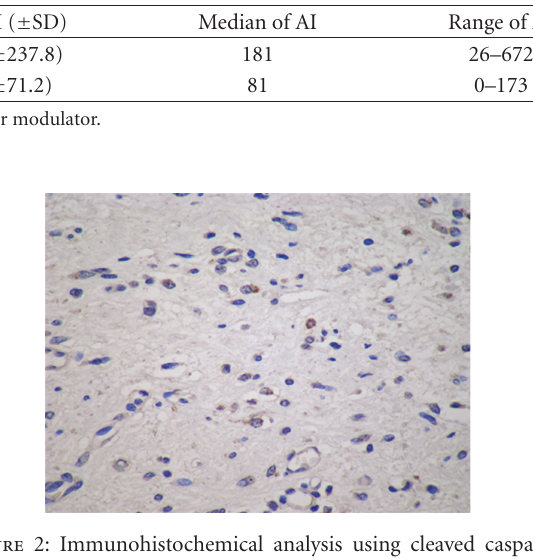
Table 3: Dependence of the number of apoptotic cells on the dose of SPRM.